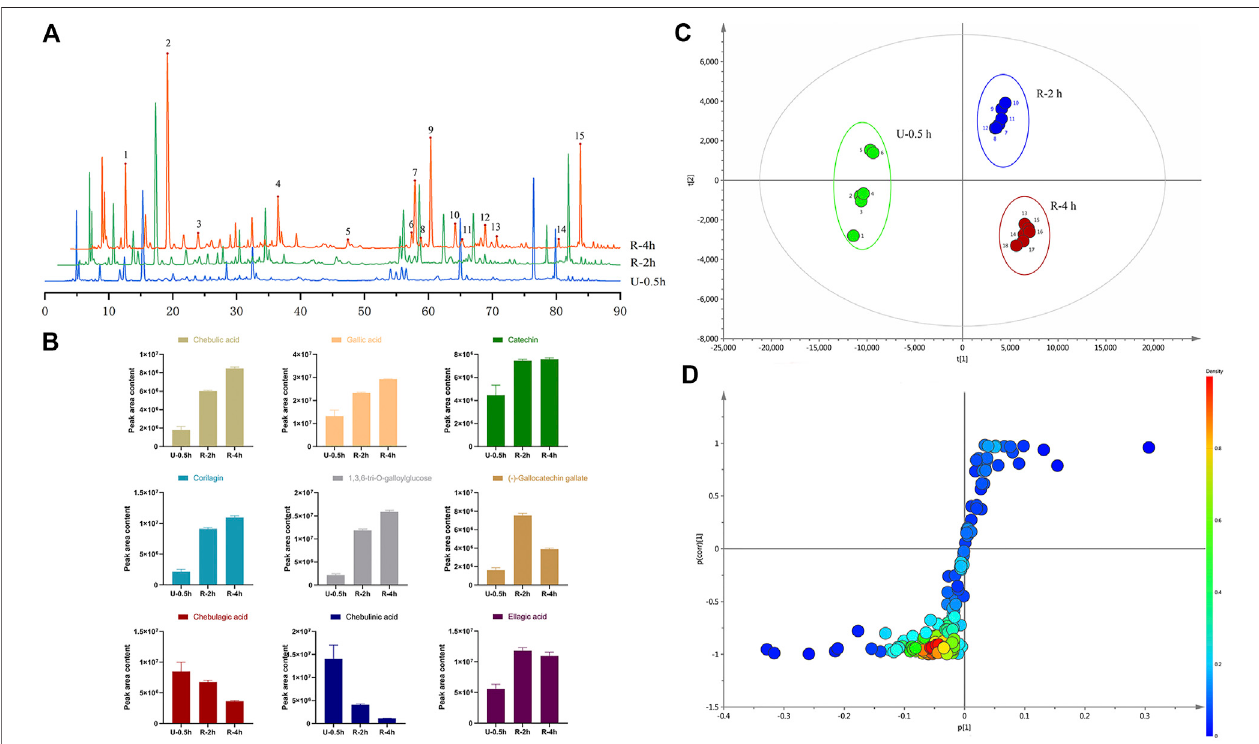
FIGURE1|(A) HPLCof Triphala indifferentextractionprocess(1.Chebulicacid,2.Gallicacid,3.Punicalin4.Catechin, 5.Epigallocatechin gallate,6.Epicatechin, 7. Corilagin, 8. Gallocatechin gallate, 9.1,3,6-tri-O-galloylglucose, 10. Epicatechin gallate, 11. Ferulic acid, 12. Chebulagic acid, 13. 1,2,3,4,6-penta-O-galloyl glucose, 14.Chebulinicacid,15.Ellagicacid). (B) Thevariationofpeakareaofcompositionindifferentdecoctiontime. (C) PCAscoreofextractsof Triphala . (D) S-plotofextracts of Triphala .